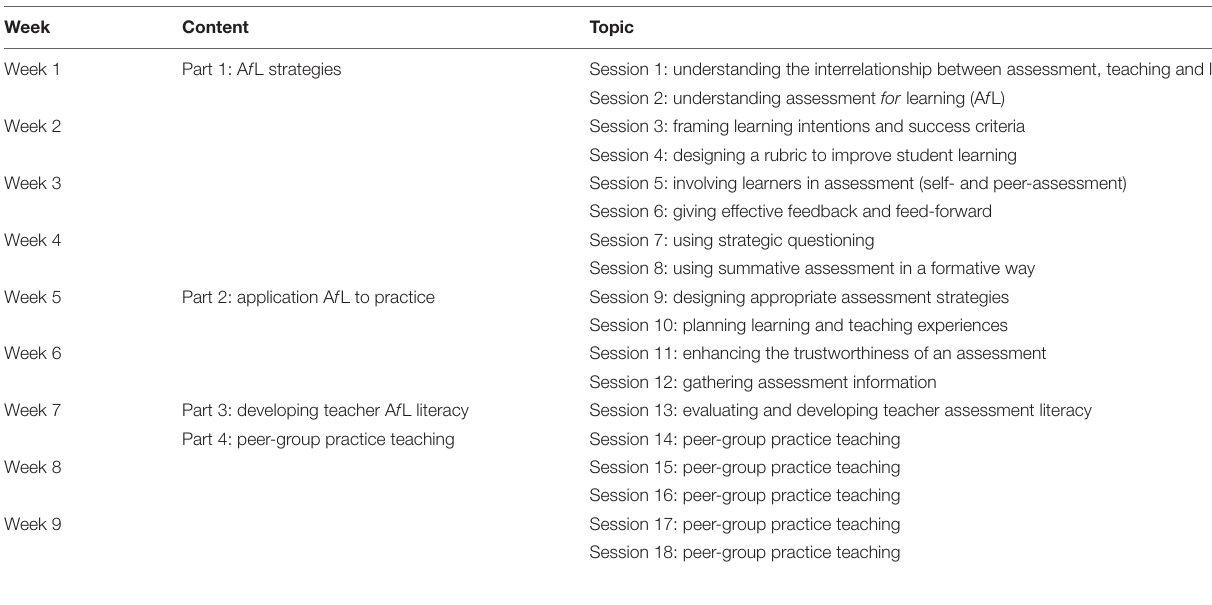
TABLE 1 | Course content and structure of the Professional Development (PD)